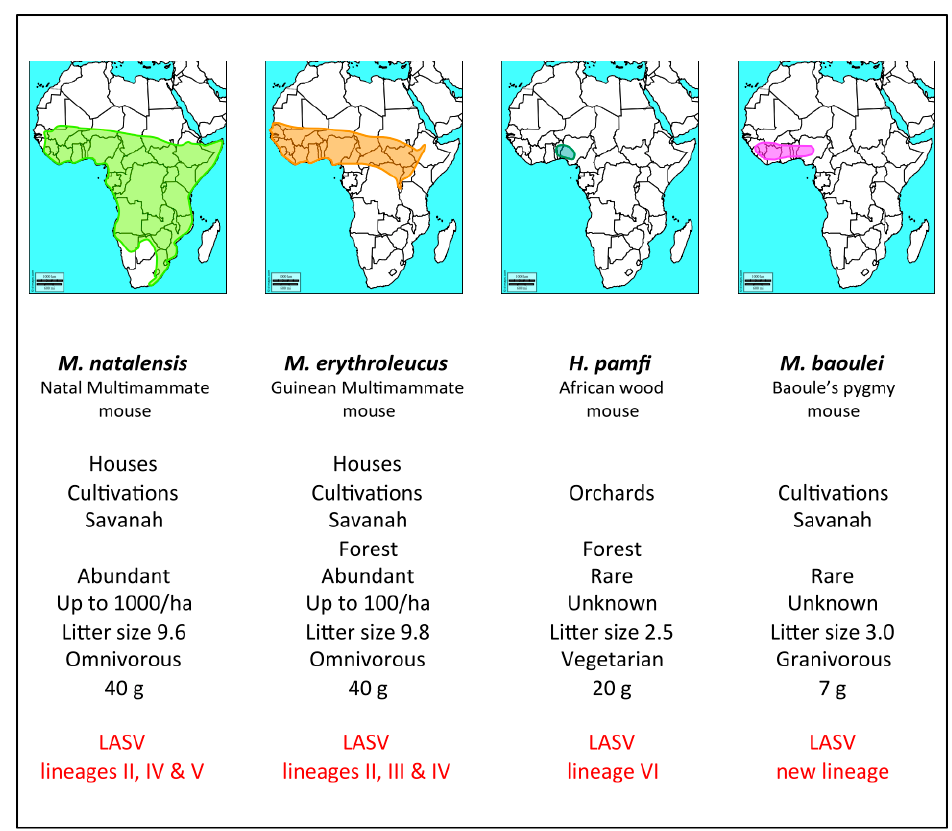
Figure 2. Distribution of the 4 host species: Mastomys natalensis , Mastomys erythroleucus , Hylomyscus pamfi , and Mus (Nannomys) baoulei in Africa with their main traits of life. The information was compiled from [4,5,12,13,24–26,30,33–38] and personal data.